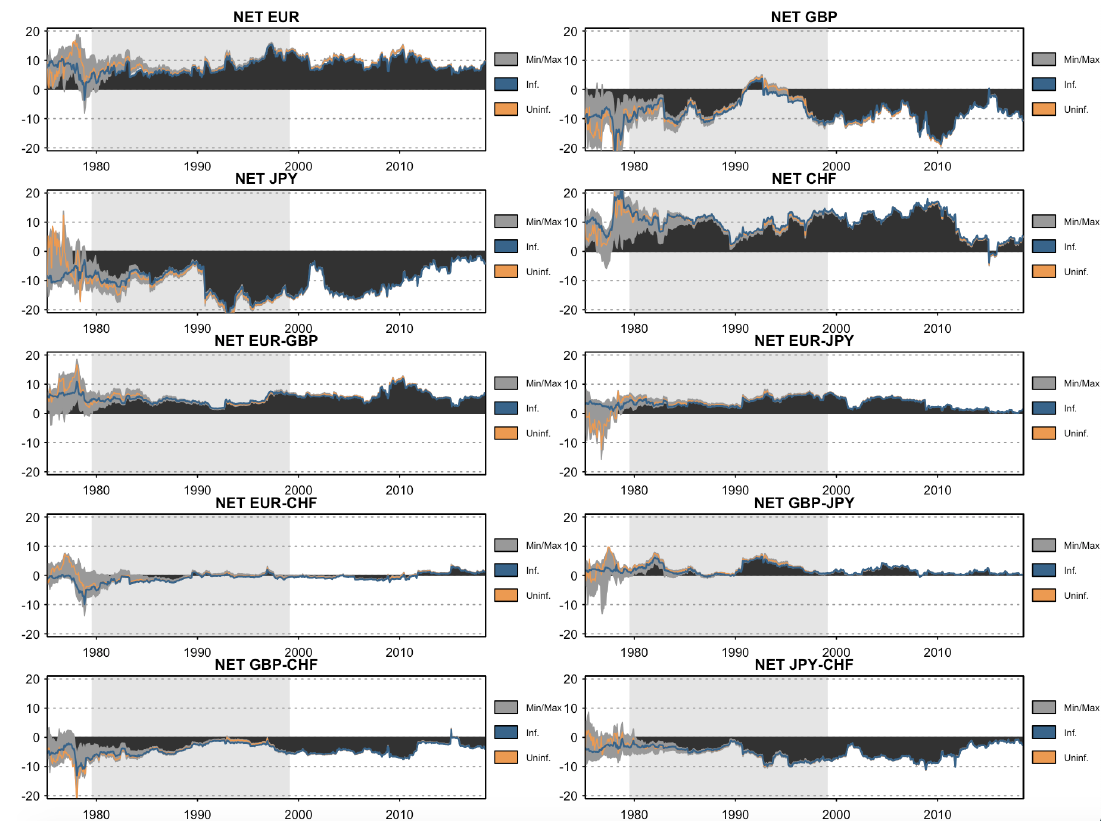
Figure 10. Prior sensitivity analysis: Net total and net pairwise directional connectedness